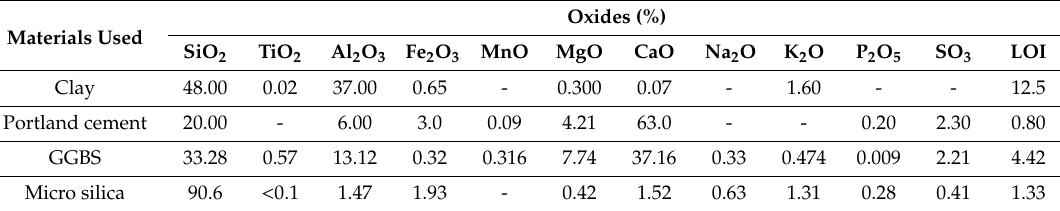
Figure 1. Distribution of particle size. Table 2. Chemical composition of materials .